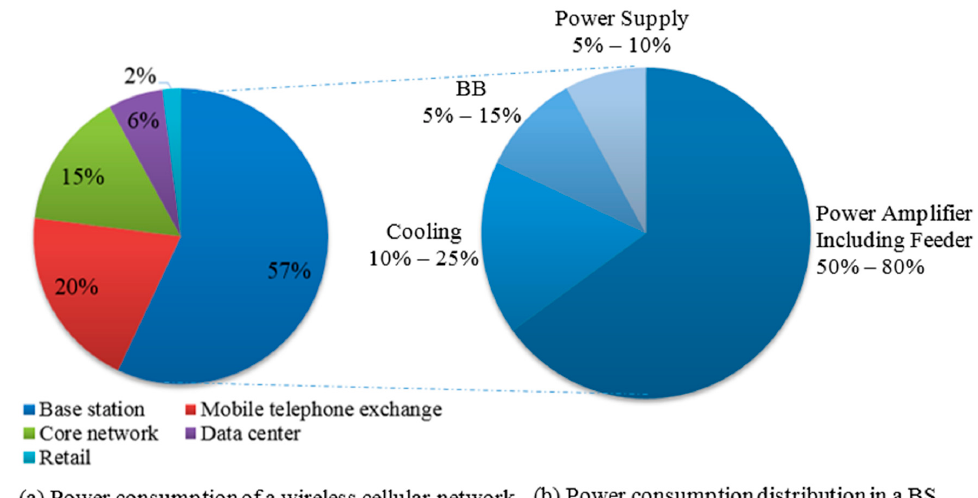
Figure 1. Breakdown of power consumption in a cellular network and BS [2,3].